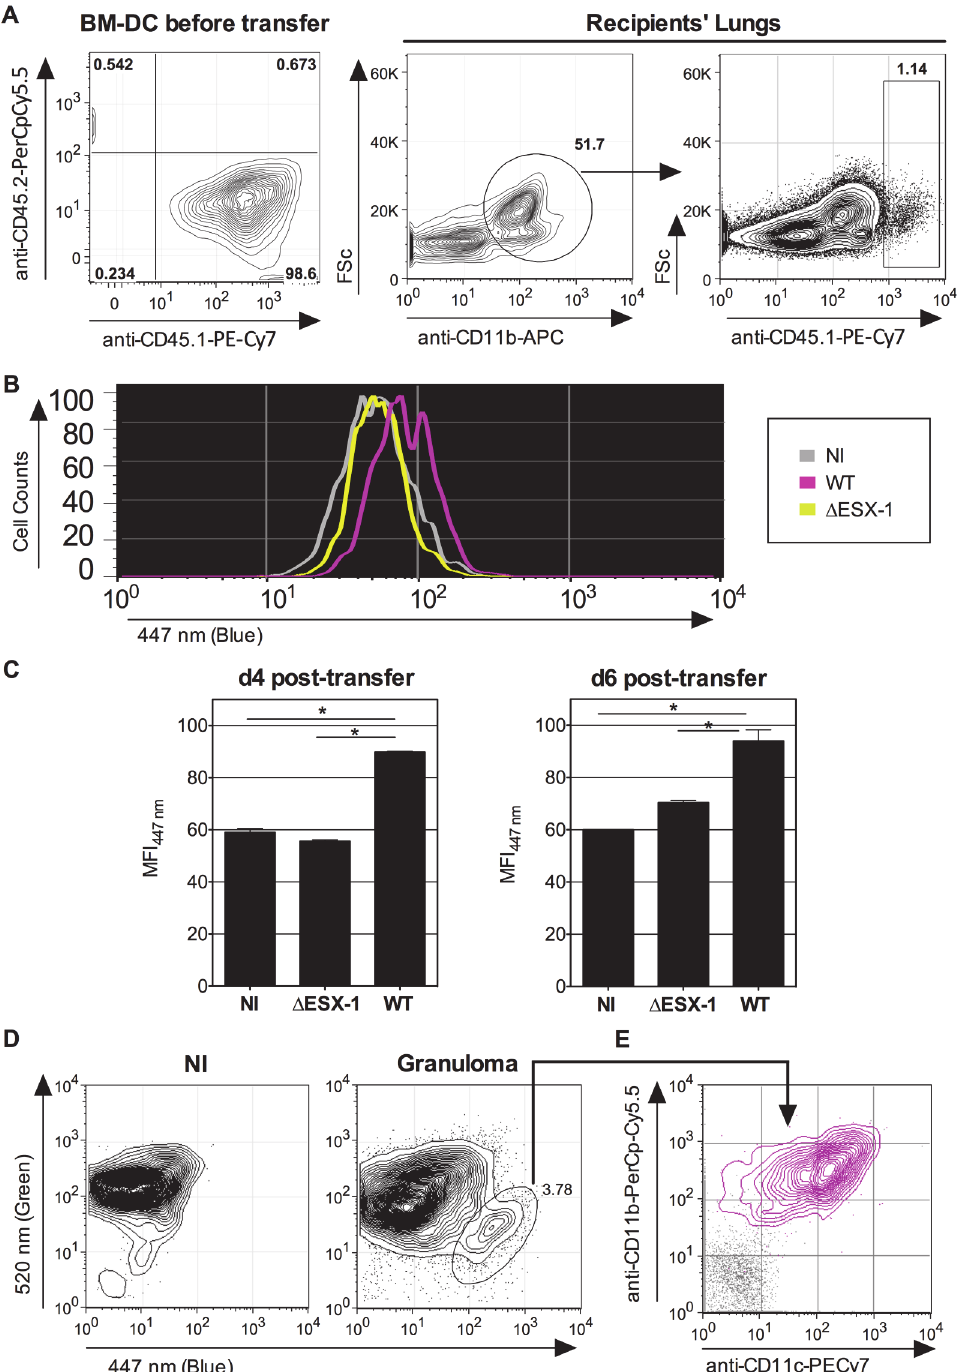
Fig 7. Detection of phagosomal rupture in vivo in Mtb -infected phagocytes. (A-B) BM-DC from CD45.1 donors were left non-infected or were infected with Mtb WT or Δ ESX-1 (MOI = 1) for 16h. Of note, cultures of CD45.1 BM-DC, infected with DsRed-mycobacteria in the same conditions, showed that > 70% of cells had uptaken mycobacteria like shown in Fig. 2A. Cells were recovered and transferred i.n. (2 x 10 6 cells/mouse) into CD45.2 congenic recipients. (B) Four days post-transfer, alive lung low-density cells from the recipients ( n = 3/group) were isolated on Optiprep gradient and incubated with mAbs specific to CD11b and CD45.1, subsequent to incubation with CCF-4. The blue signals from the three experimental groups are overlaid. (C) Histograms show the comparative blue CCF-4 signals in the CD11b + CD45.1 + cells from different groups at days 4 or 6 post transfer. * = statistically significant, as determined by the Student's t test, p < 0.01. (D) Lung granuloma from C57BL/6 mice, infected via aerosol route with (cid:1) 200 CFU/mouse of WT Mtb , were removed at 6 weeks p.i. and were treated with collagenase and DNAse-I and enriched in low-density cells. In parallel to these cells, lung low-